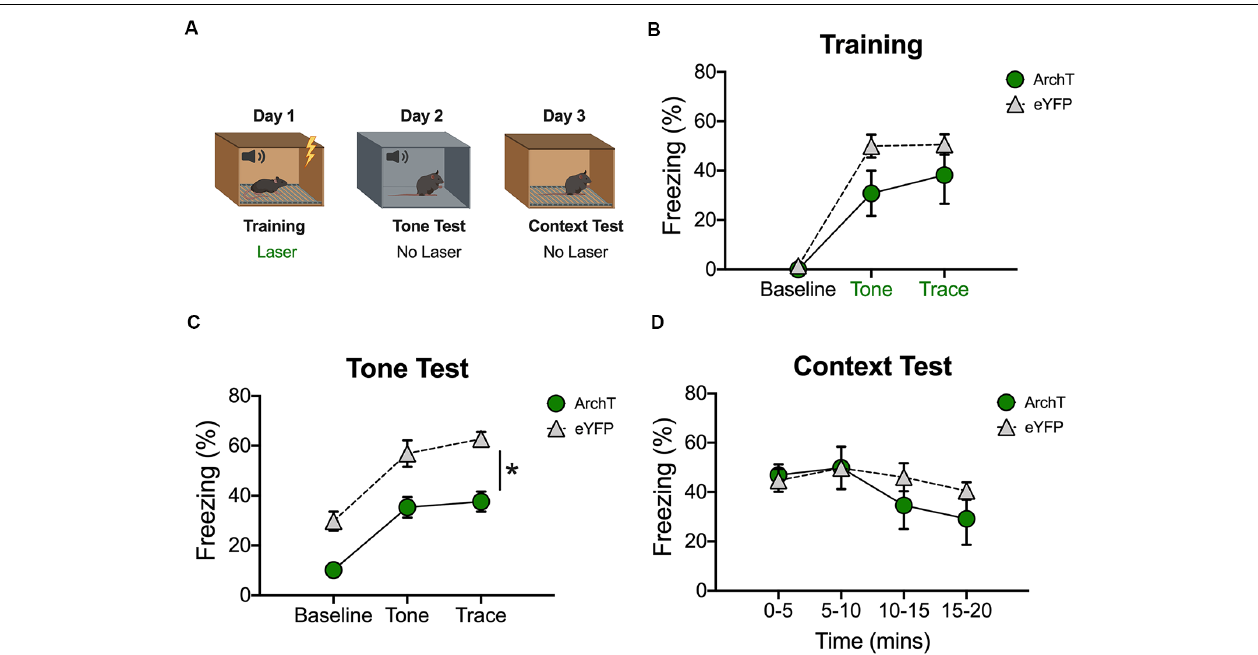
FIGURE 4 | Inhibition of dCA1 during trace fear encoding impairs memory acquisition. (A) Schematic of behavioral paradigm. On day 1, animals underwent trace fear conditioning with green light delivered to dCA1 during each training trial. The next day, mice underwent a tone memory test in a novel context with no laser stimulation. Twenty-four hours later, mice were placed back in the conditioning environment for a context memory test without light delivery. (B) Freezing during the training phase of trace fear conditioning (Mean ± SEM). (C) Freezing during the tone test (Mean ± SEM). (D) Freezing during the context test (Mean ± SEM). In all behavioral panels, green represents the ArchT group and gray represents the control group. Green x-axis labels denote periods during which the laser was delivered. ∗ p < 0.05 relative to control.